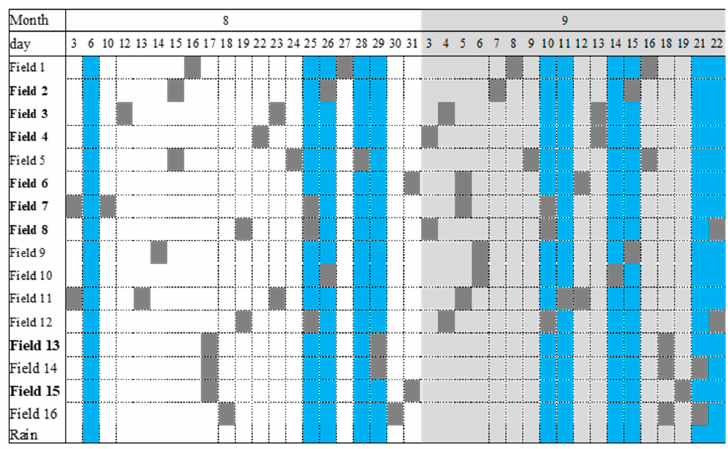
Figure A1. A description of the vineyard fields drip irrigation schedule. The blue color represents the rainfall events. The light grey color di ff erentiates between the months of August and September. The dark grey color represents the irrigation events over the individual